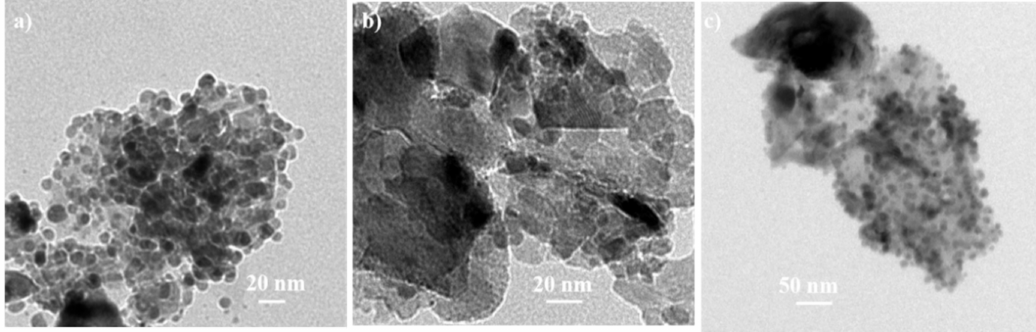
Figure 5. TEM image of synthesized Ag-Co alloys. ( a ) AgCo-11; ( b ) AgCo-12; and ( c )